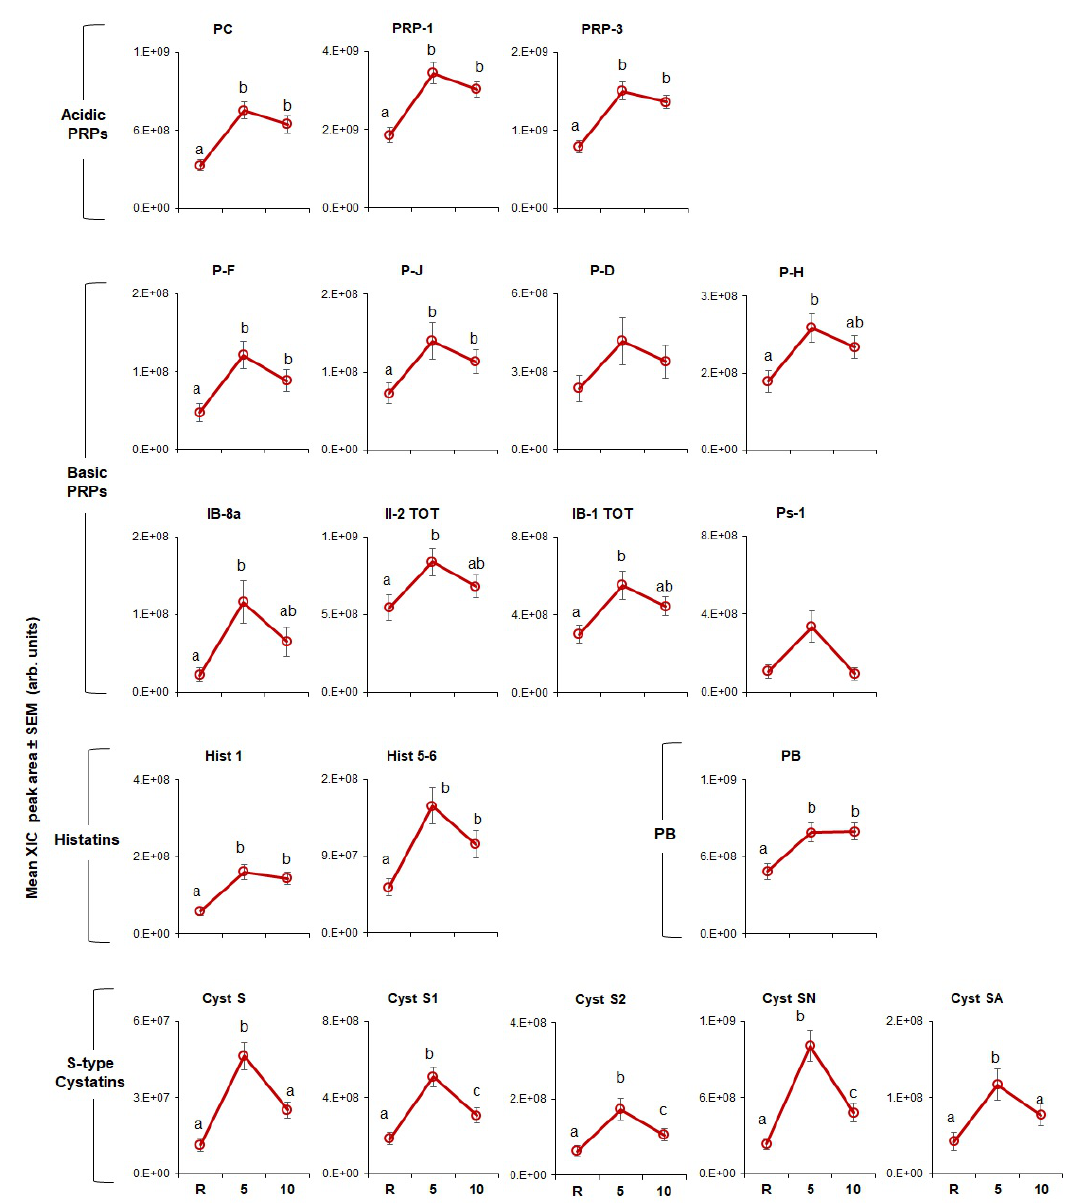
Figure 4. E ff ect of stimulation with CJ on levels of individual salivary proteins. Mean extracted ion current (XIC) peak areas ± SEM ( × 10 8 arbitrary units) of individual proteins measured at resting (R), 5 min (5) and 10 min (10) after stimulation ( n = 60). Means within protein type with di ff erent superscript letters (a, b, etc.) are di ff erent at p <